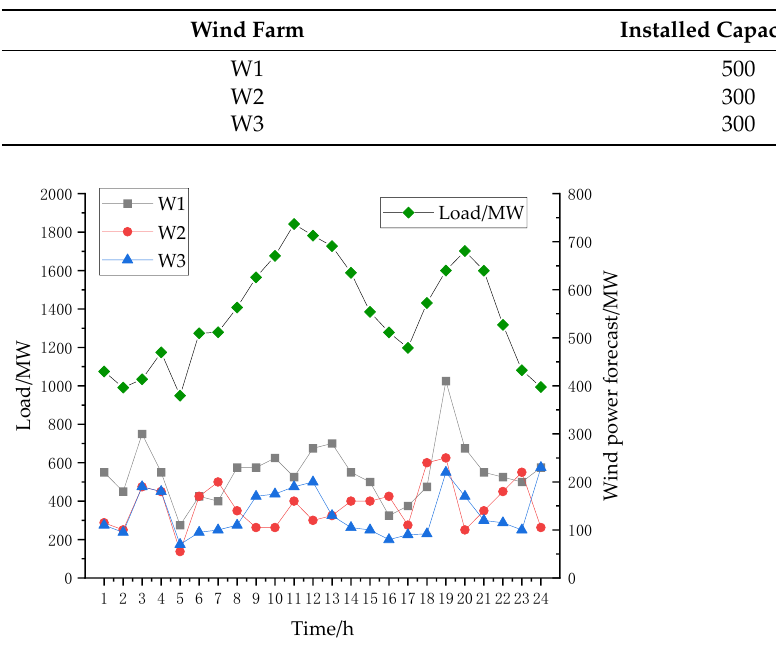
Figure 5. Daily load curve of a northwestern province and daily forecast curves of three wind farms.